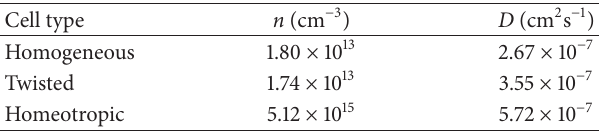
Table 1: Ion concentration n and diffusion constant D in E7 for homogeneous, twisted, and homeotropic cells at